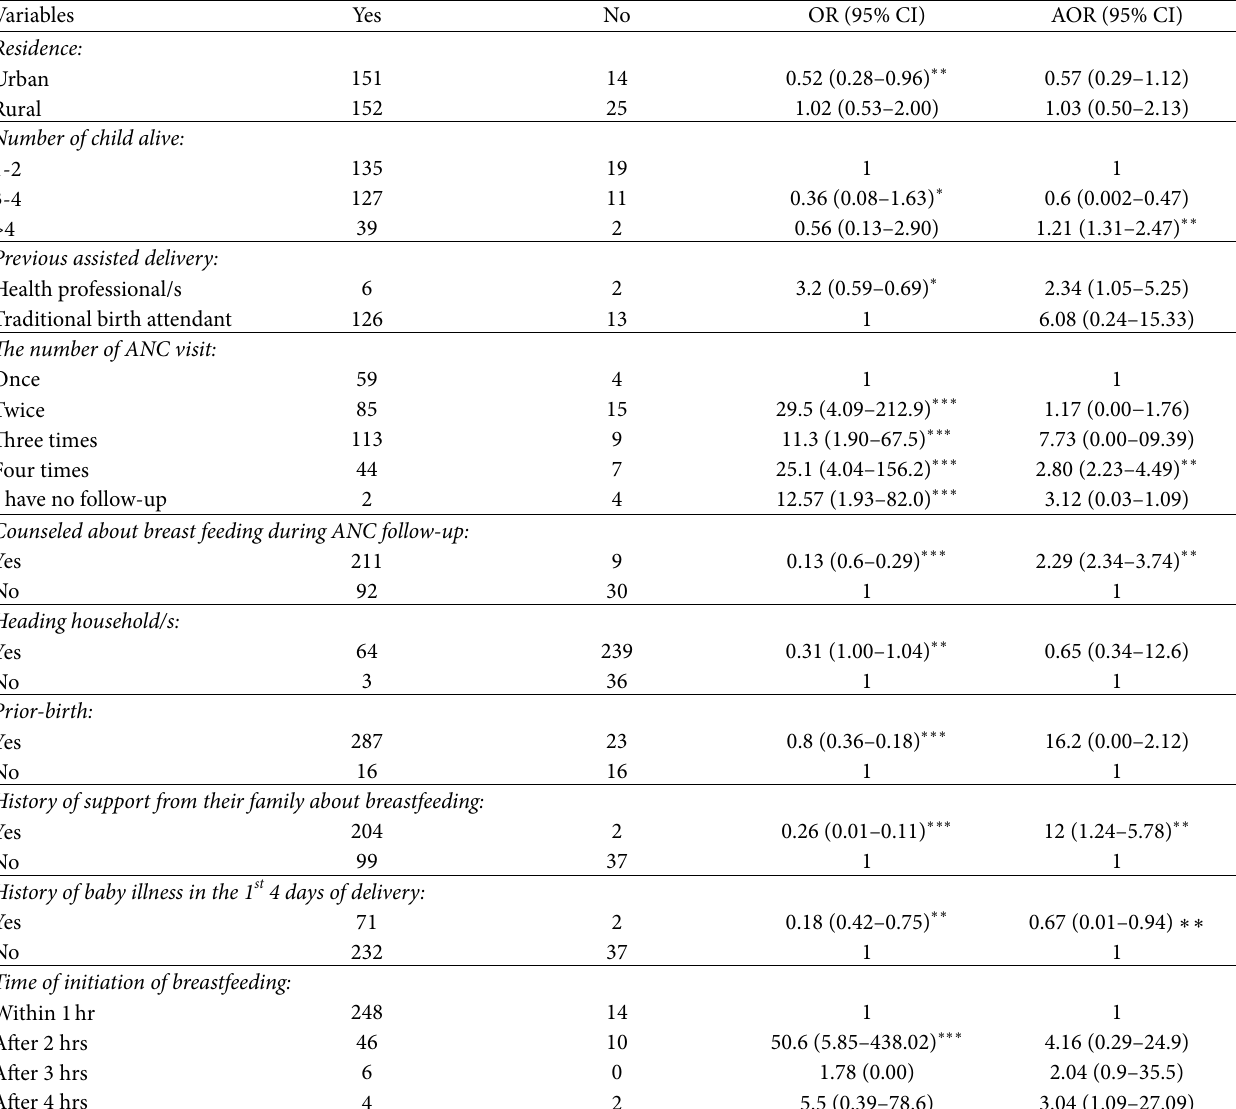
Table 5: Bivariate and multivariate logistic regression analysis of knowledge of colostrum feeding and its explanatory variables ( 𝑛 = 342 ) (N.B: yes = knowledgeable and no = not